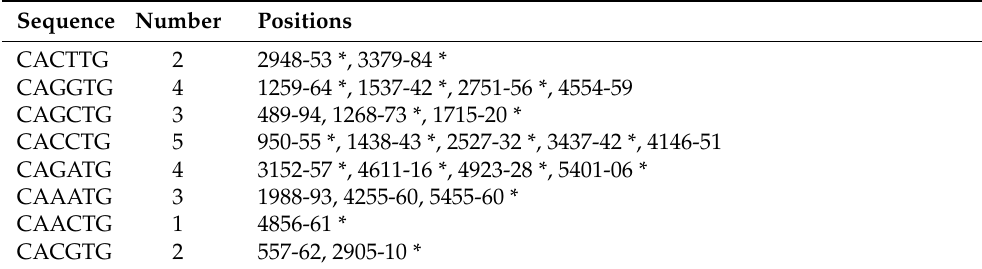
Table 5. The number and positions of E-box hexanucleotide consensus sequence (CANNTG) in KLF4 transcription unit. The asterisks indicate exonic E-boxes.